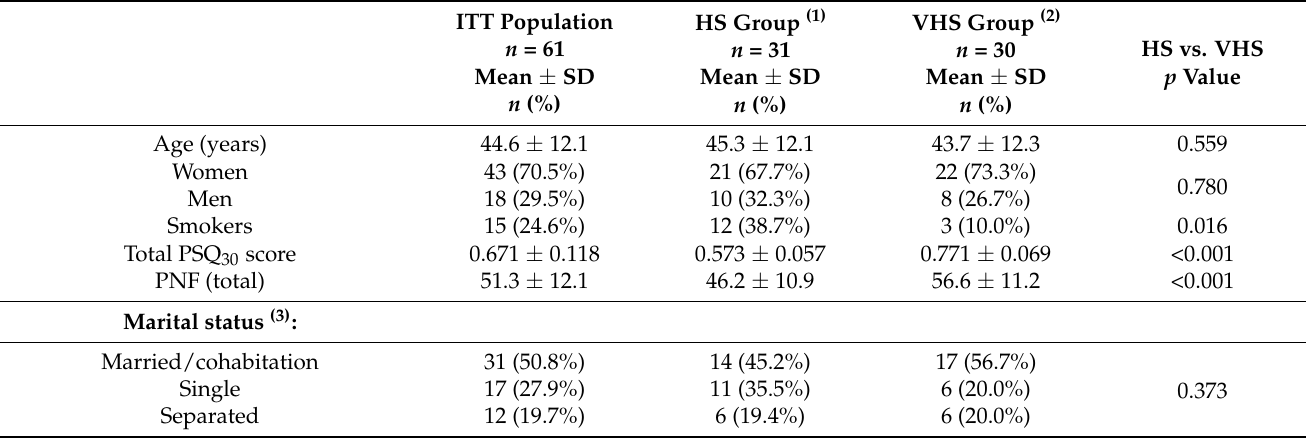
Table 1. Characteristics of